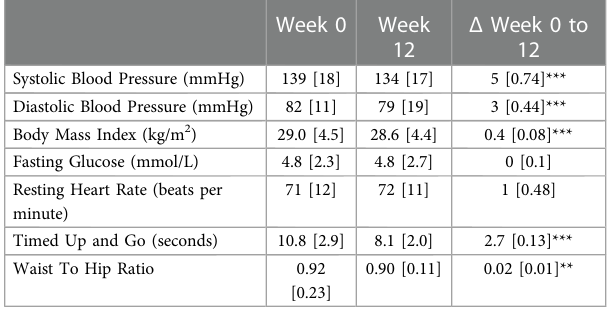
TABLE 3 General health pre- and